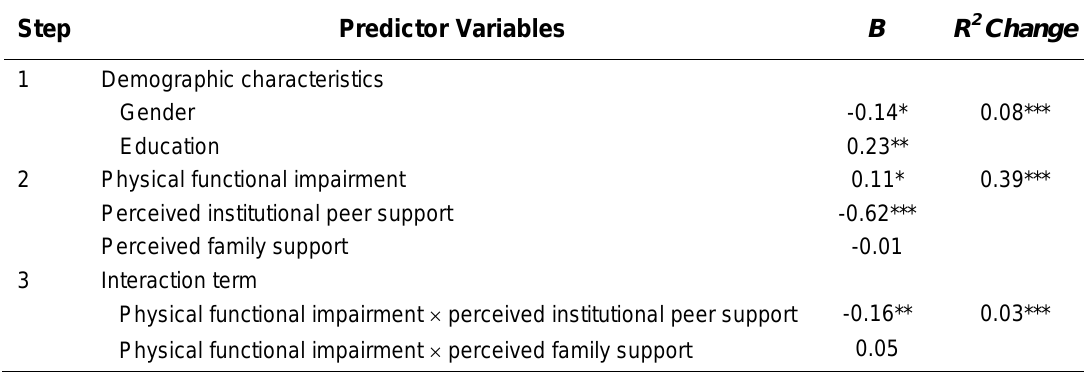
Hierarchical Regression Analysis for the Prediction of Elderly